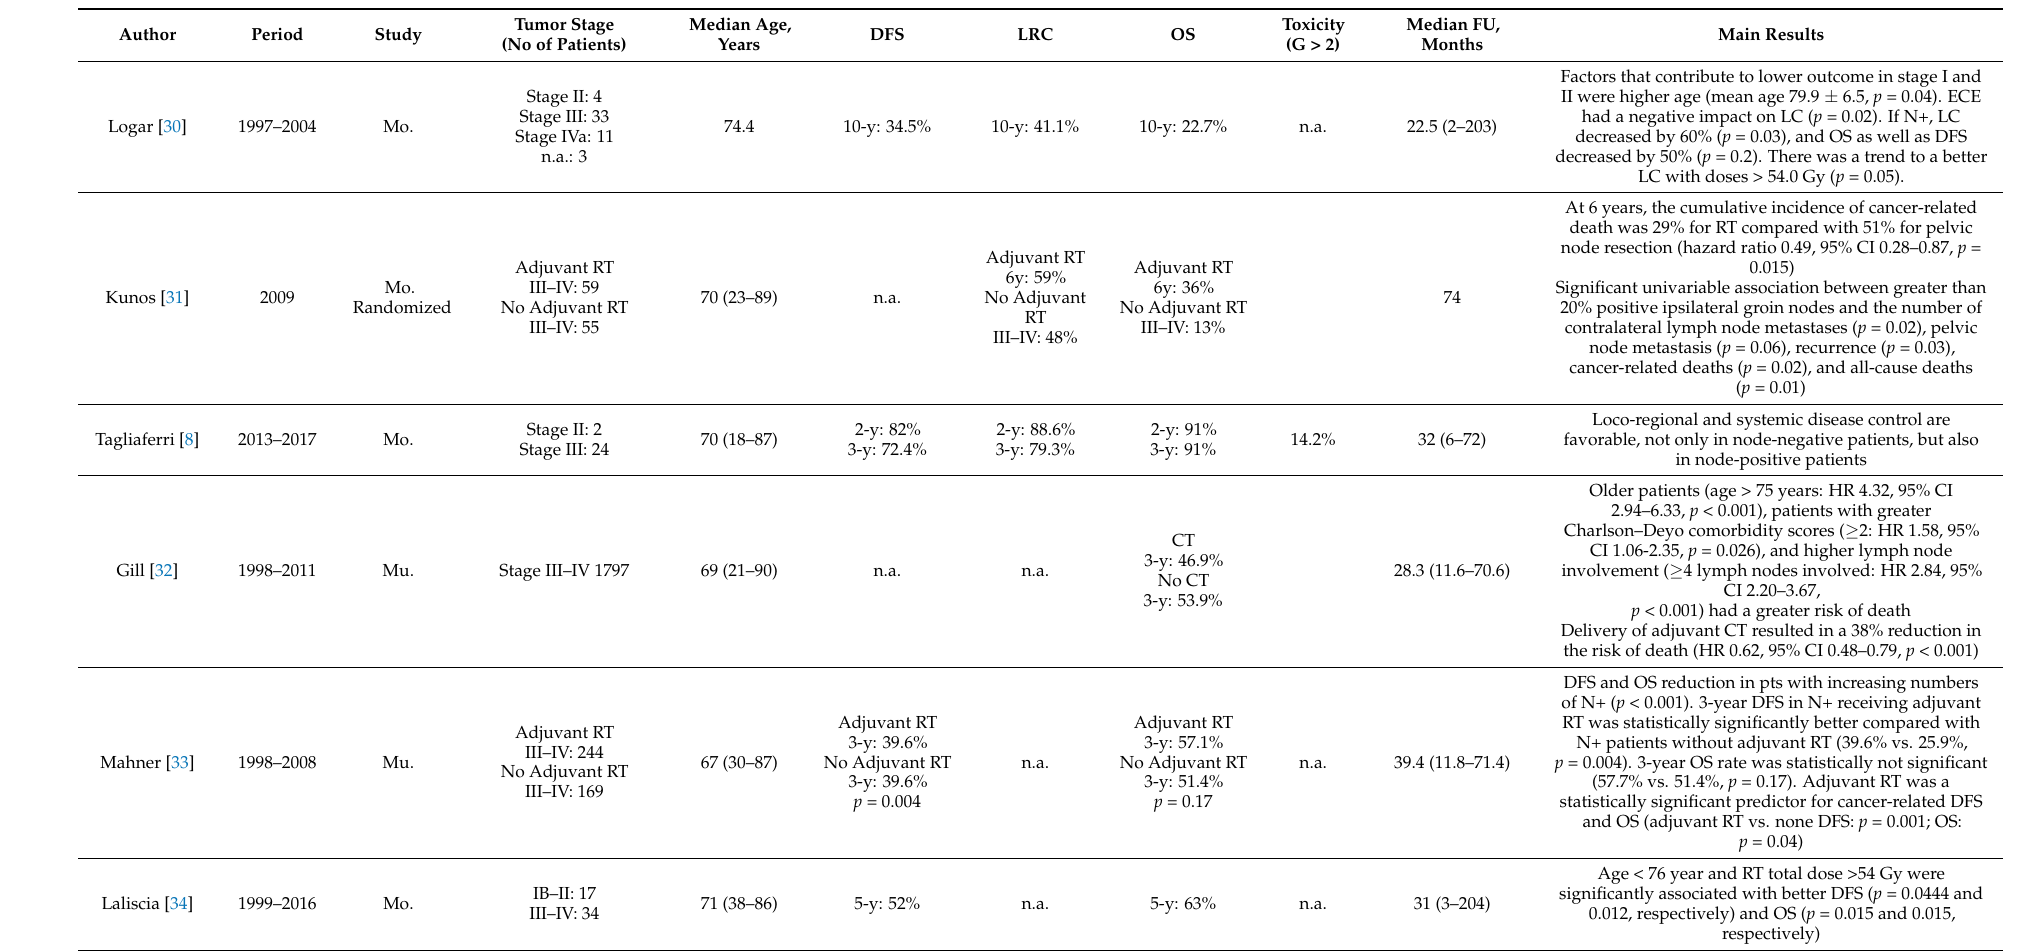
Table 3. Adjuvant